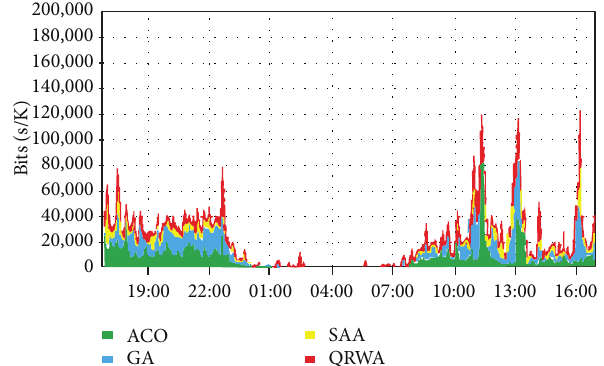
Figure 5: The throughput of HP rx4640 in ACO, GA, SAA, and QRWA during one day.